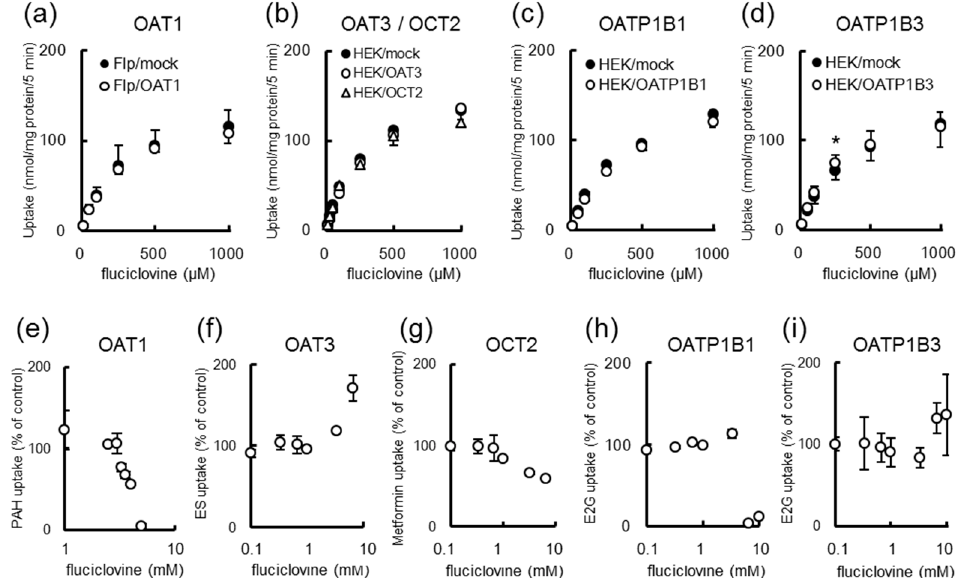
Figure 5. ( a – d ): The concentration dependency of the [ 14 C]fluciclovine uptake in ( a ) organic